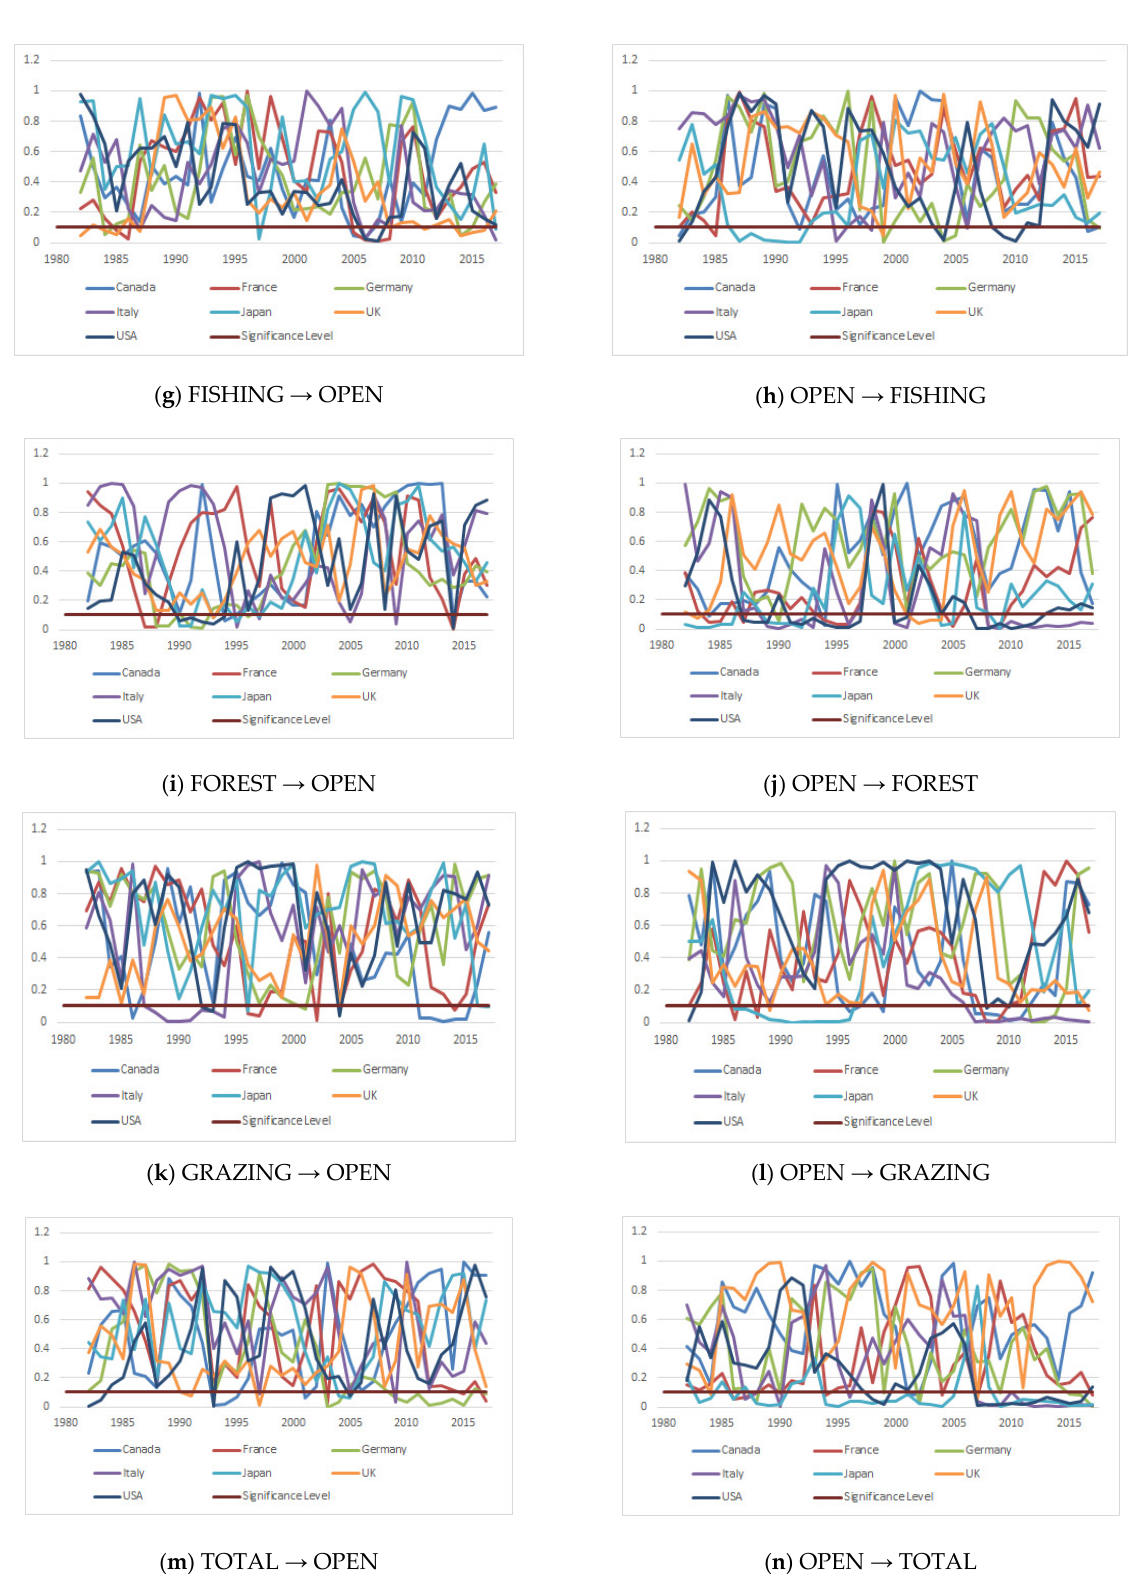
Figure 1. The results of the symmetric panel causality test.